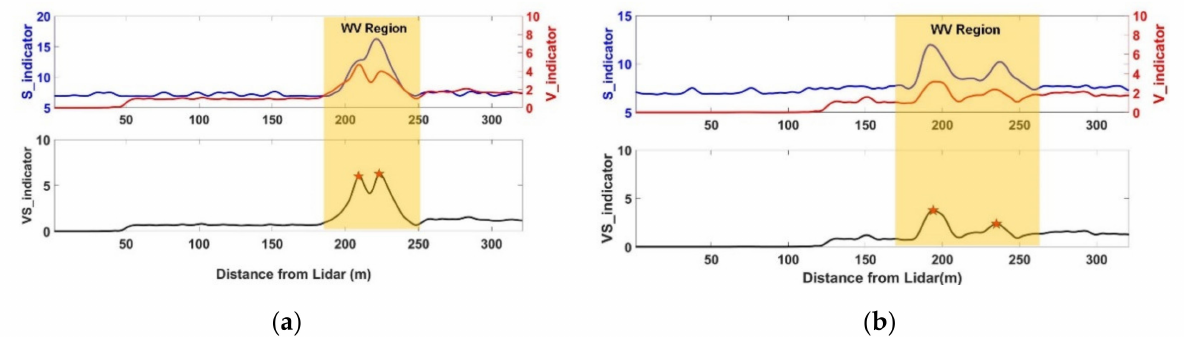
Figure 6. Horizontal position identification of wake vortex cores in different situations: ( a ) the single peak of fusion spectrum width, and ( b ) insignificant bimodal structure of V indicator